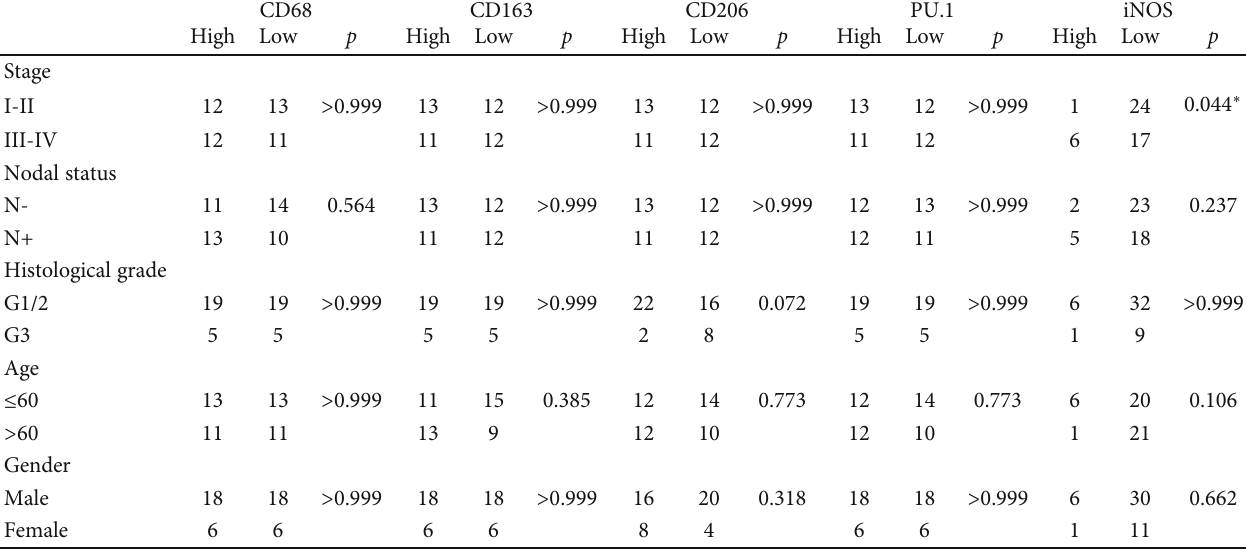
Table 2: Clinicopathological characteristics and TAM markers in